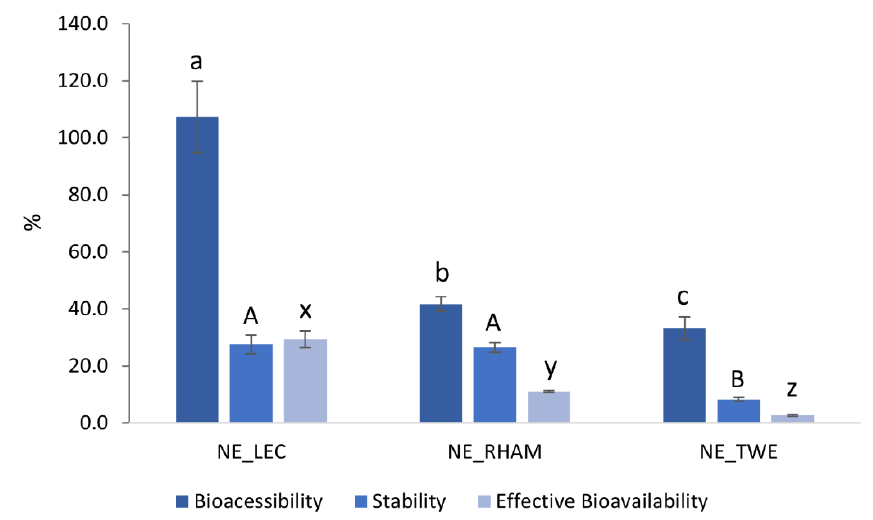
Figure 5. Bioaccessibility, stability, and effective bioavailability of curcumin loaded in nanoemulsions (NEs) with different emulsifiers (lectithin (LEC), rhamnolipids (RHAMs), and Tween ® 80 (TWE)) after in vitro digestion process. Error bars represent the standard deviation of n = 6 replications. Different letters indicate statistically significant differences between NEs in a–c bioaccessibility, A,B stability, and x–z effective bioavailability ( p < 0.05).